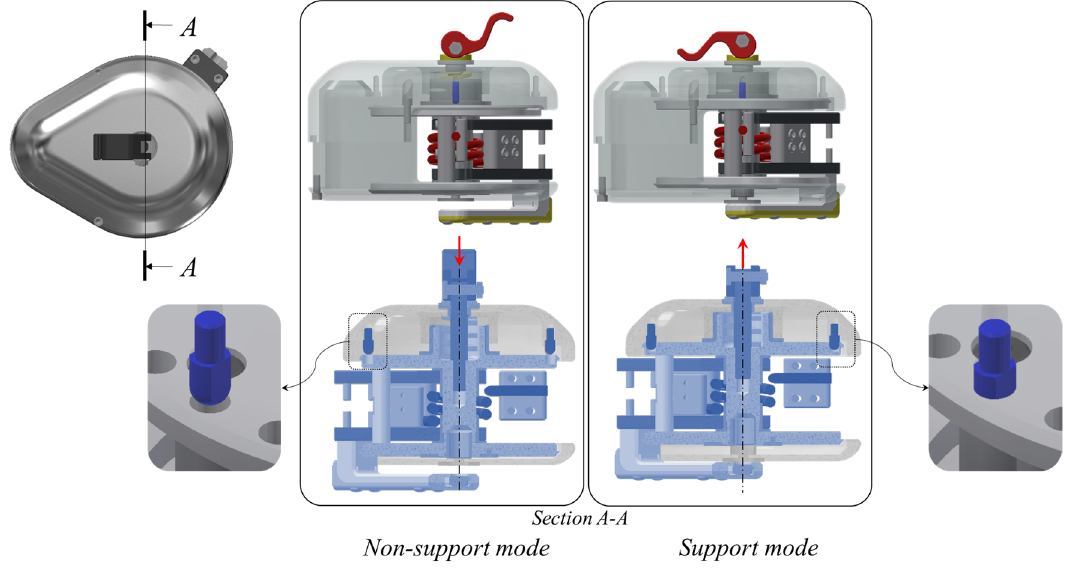
Figure 7. The illustration of operation of the support mode and non-support mode of the gravity